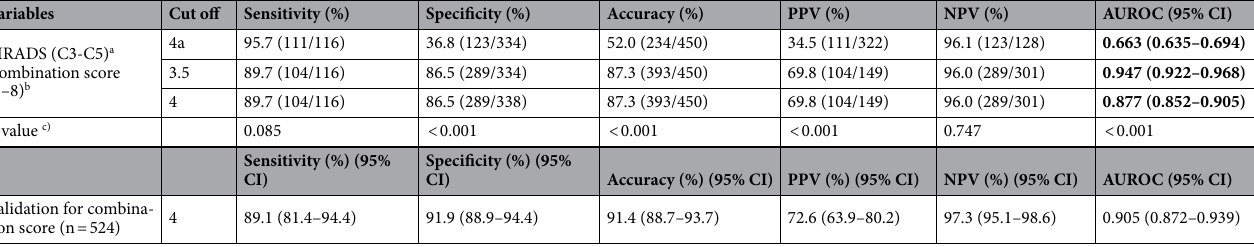
Table 2. Comparison of diagnostic performance between BI-RADS alone and combined BI-RADS, SWEmax, SWEratio and SMI VI scores. Significant values are in bold. a For the evaluation of the diagnostic performance of B-mode ultrasound alone, BI-RADS categories were benign for category 3 and malignant for category 4a or higher. b To calculate the combination score, BI-RADS categories were scored 1 to 5 (C3: 1, C4a: 2, C4b: 3, C4c: 4, and C5: 5) and quantitative parameters of SWE and SMI were scored 0 or 1 according to each cutoff value and ranged from 1 to 8 score. c Diagnostic performances of B-mode alone and combined score were compared. PPV: Positive predictive value, NPV: Negative predictive value, AUROC: Area under the receiver operating characteristics curve, CI: Confidence